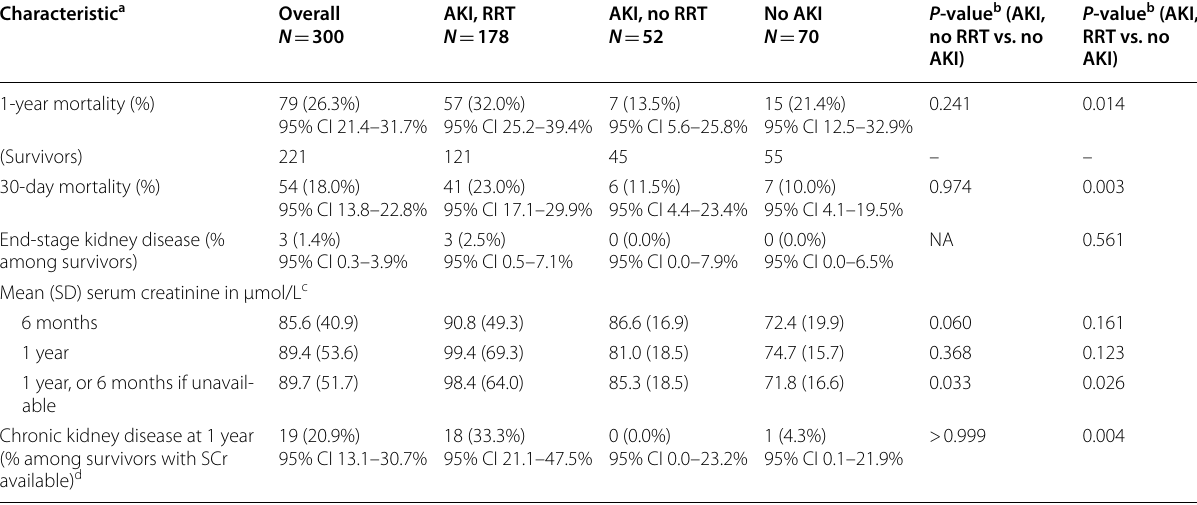
Table 3 Primary and secondary outcomes at 1 year by acute kidney injury and renal replacement therapy status